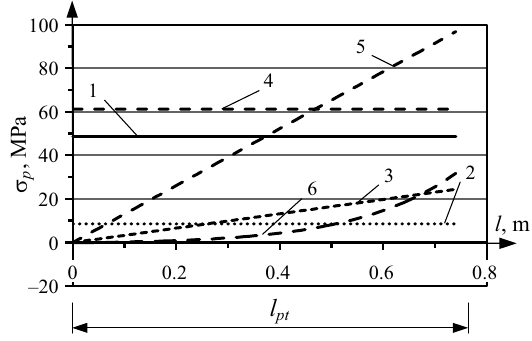
Fig. 5. Distribution of pretensioned strand prestress